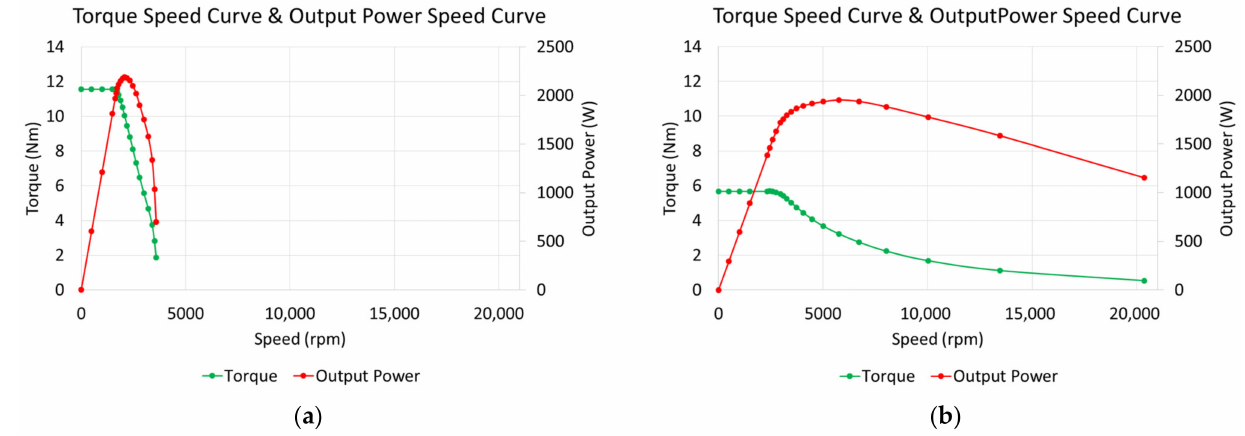
Figure 17. Torque-speed and output power-speed curve of the final type of design that produces